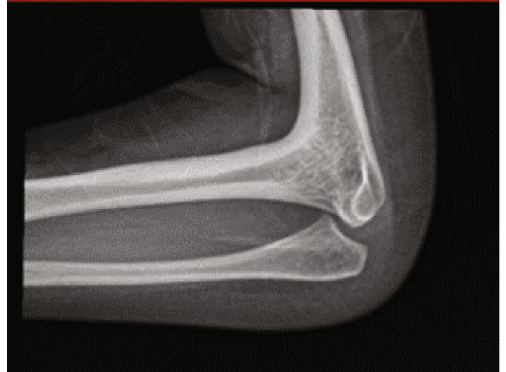
Figure 3: An X-ray of the left elbow demonstrating fusion of proximal radius to the distal